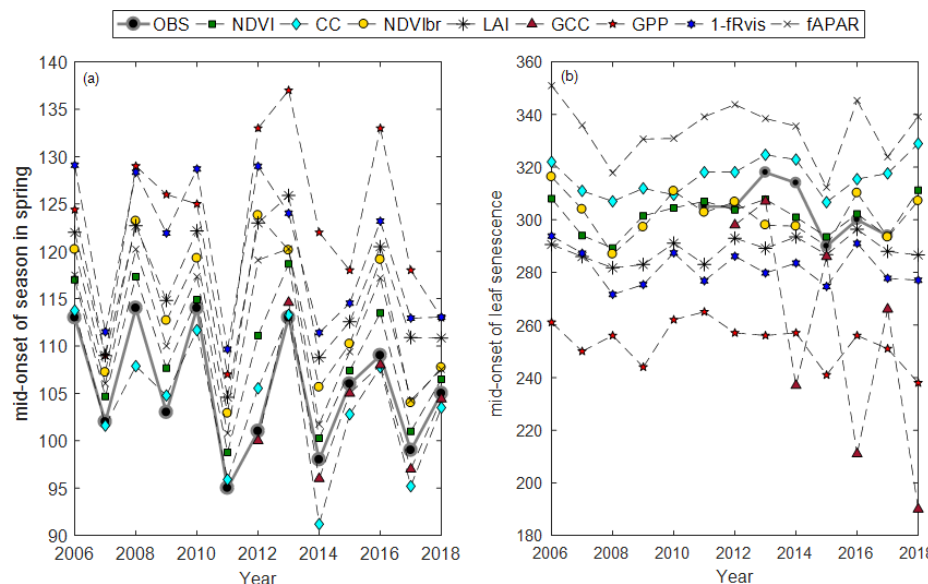
Figure 3. Average phenological dates in spring (a) and autumn (b) using MOS and MOF phenological markers, respectively, and for the different years.